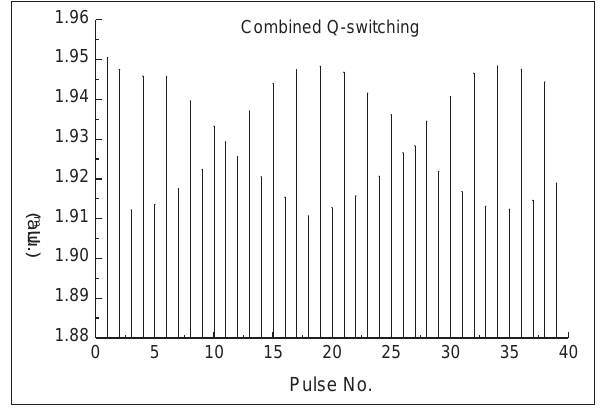
Figure4.Typicalpulsetrainobtainedusingmicrochiplaserwithcombinedpassiveand